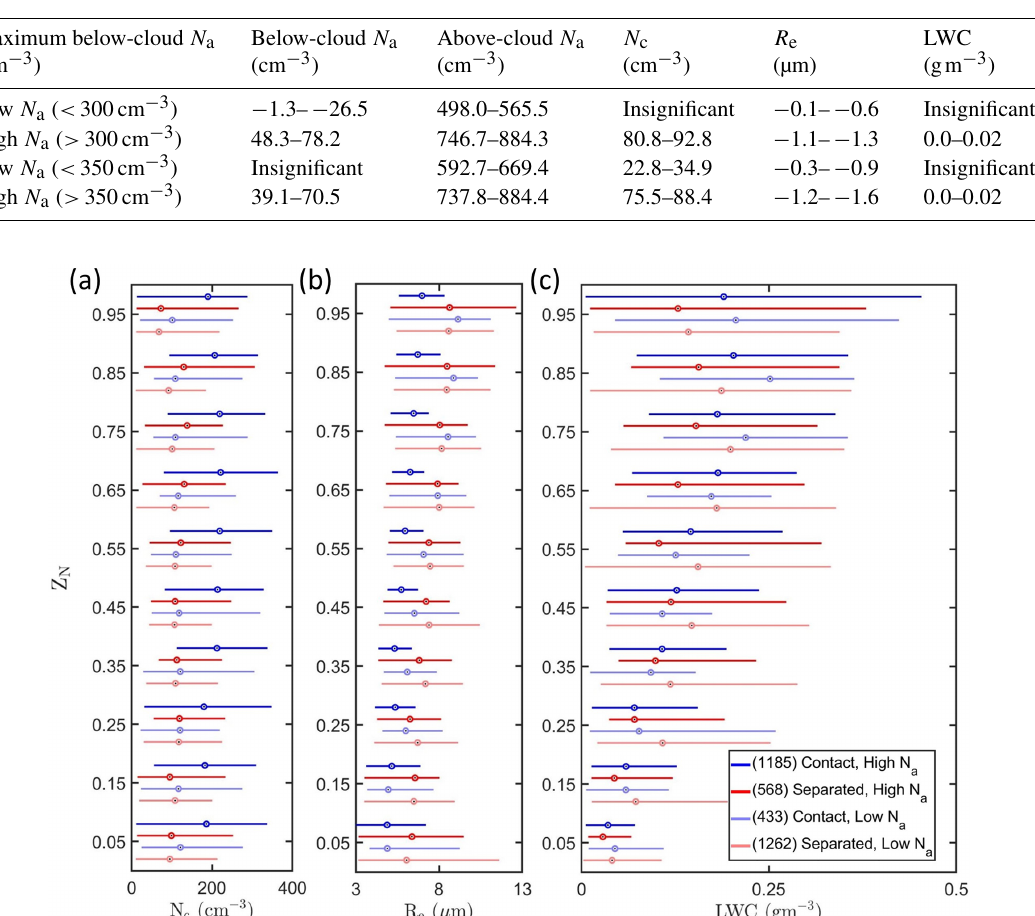
Figure 12. Boxplots representing vertical profiles of (a) N c , (b) R e , and (c) LWC as a function of Z N for contact (blue) and separated (red) profiles within boundary layers with high N a ( > 350cm − 3 ) (darker) or low N a ( < 350cm − 3 ) (lighter). The number of 1Hz measurements within each regime is listed within